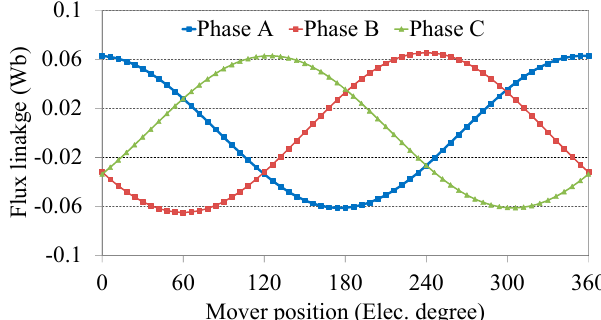
Figure 6. 3-phase flux linkage waveforms of Machine III.